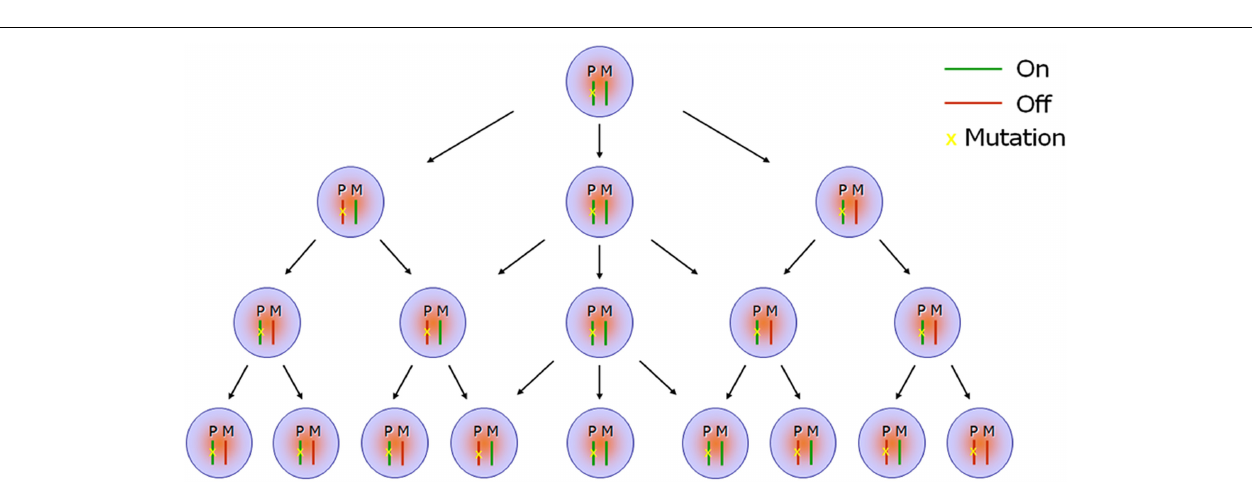
FIGURE 2 | Scheme of monoallelic expression in developing organs. Random monoallelic expression (RME) occurs in maternal or paternal alleles (i.e., turned “On” or turned “Off”) stochastically in the developing embryos, which results in a mosaic expression signature (monoallelic, biallelic, or null) in a specific tissue or across different tissues. When one of the parental alleles is mutant—for example, the paternal allele as indicated in the scheme (P: paternal; M: maternal)—the mosaic expression profile further generates co-existence of discrepant protein composition or function in a proportion of cells, attributable to random inactivation of the wild-type maternal allele. For instance, cells showing haploinsufficiency for a particular gene will co-exist alongside cells completely lacking functional protein when the gene mutation is